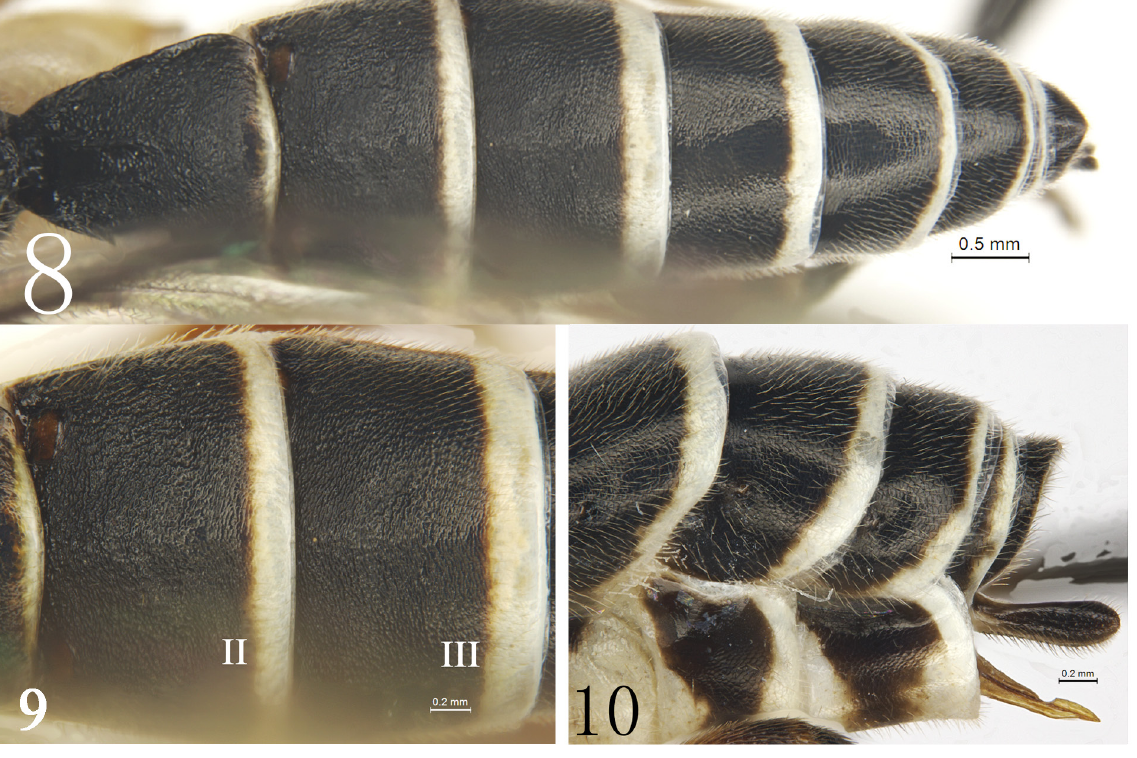
Figs 8–10. Campodorus albilineatus Sheng, Sun & Li sp. nov., holotype, ♀ (GSFGPM). 8 . Metasoma, dorsal view. 9 . Tergites 2–3, dorsal view. 10 . Apical portion of metasoma, lateral